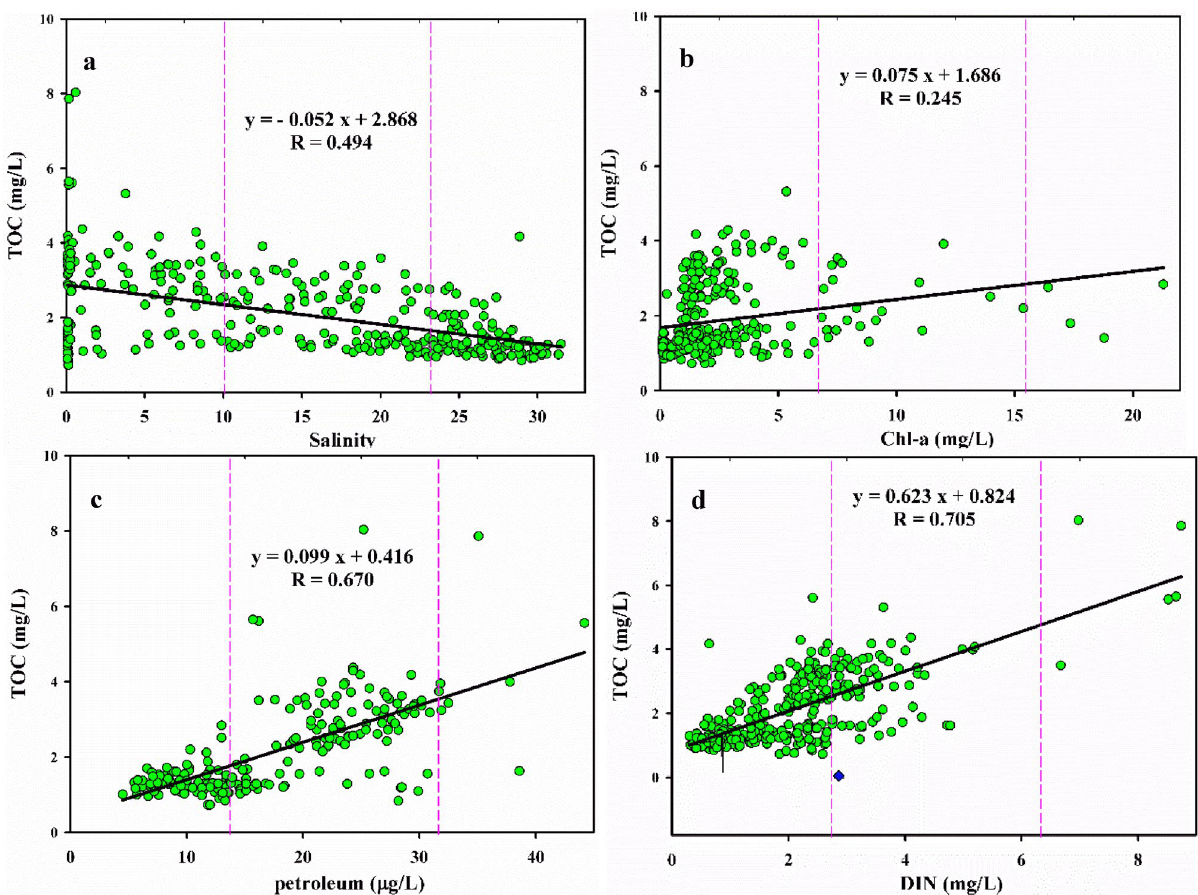
Figure 4. Relationship between TOC concentration and environmental parameters. These figures were prepared using Sigma-Plot Version 10.0 (Systat Software, Inc., San Jose, California,